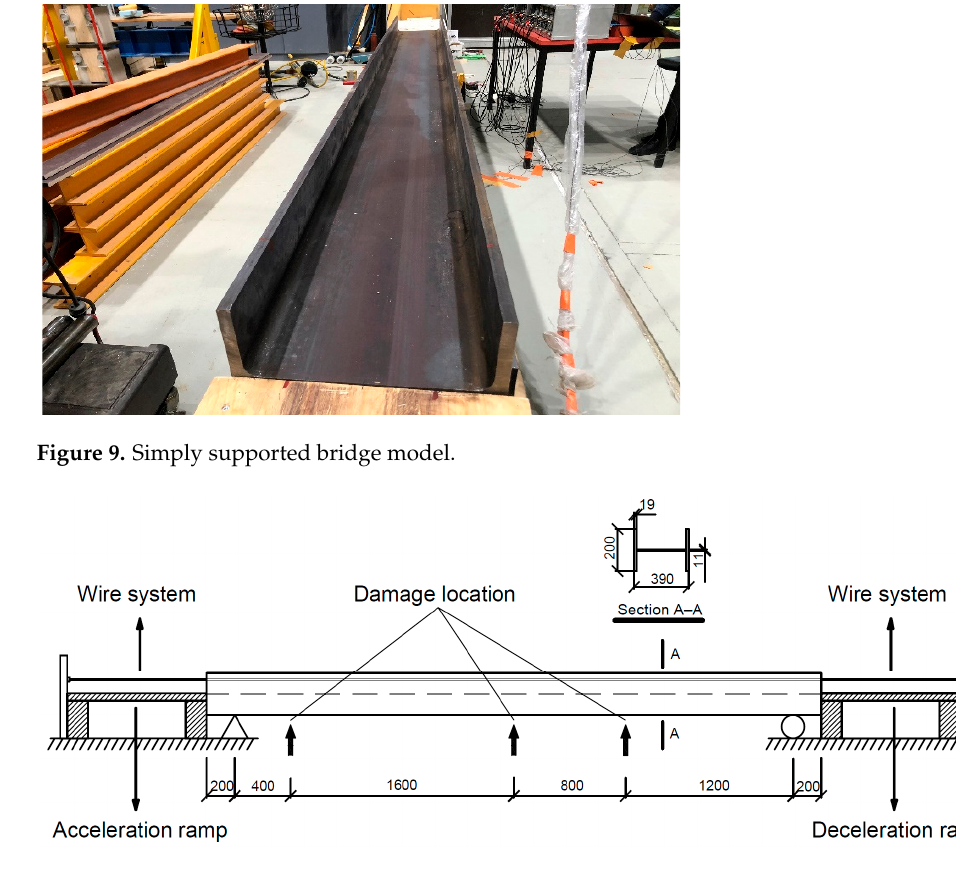
Figure 10. Details of the bridge model setup (unit: mm).